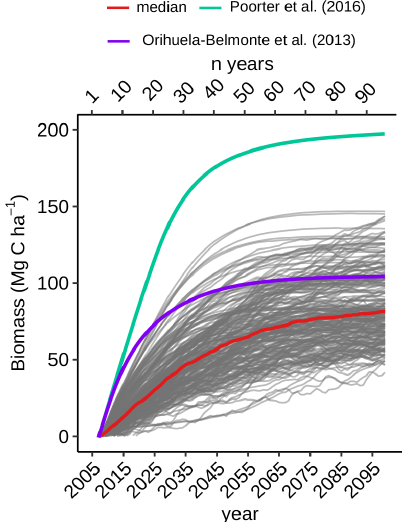
Figure A5. Aboveground biomass change in regenerating broadleaf forest in the restoration simulation. Modelled median increase (red) compared to observations (Orihuela-Belmonte et al., 2013; Poorter et al., 2016). Regenerating broadleaf forests are defined as grid cells with an increase in broadleaf PFTs of > 30% of grid cell value.